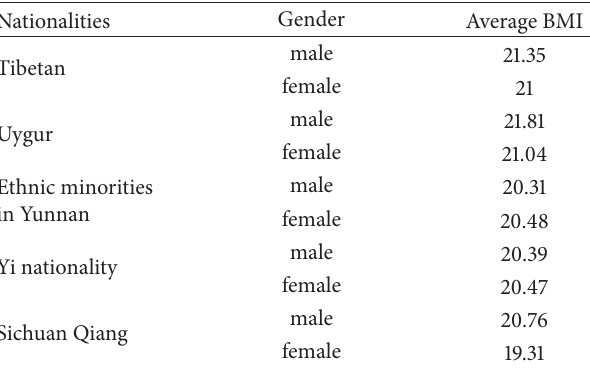
Table 4: Comparison of BMI averages between Tibetan and Uygur university students and other nations in South China.